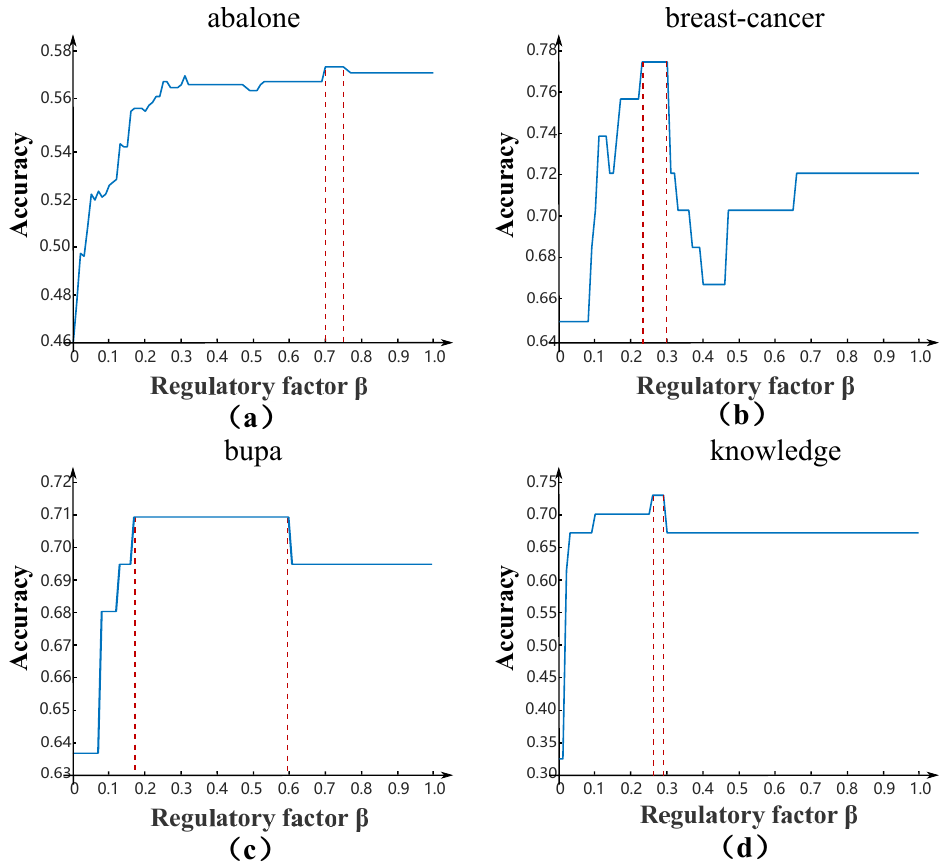
Figure 2. The optimal regulatory factor β of RQRF and SLS algorithms in four datasets. The blue solid line represents the accuracy of each step size by SLS, and the red dotted lines represent the optimal interval obtained by RQRF. Table 4. The optimal interval of regulatory factor β and the runtime from SLS and RQRF